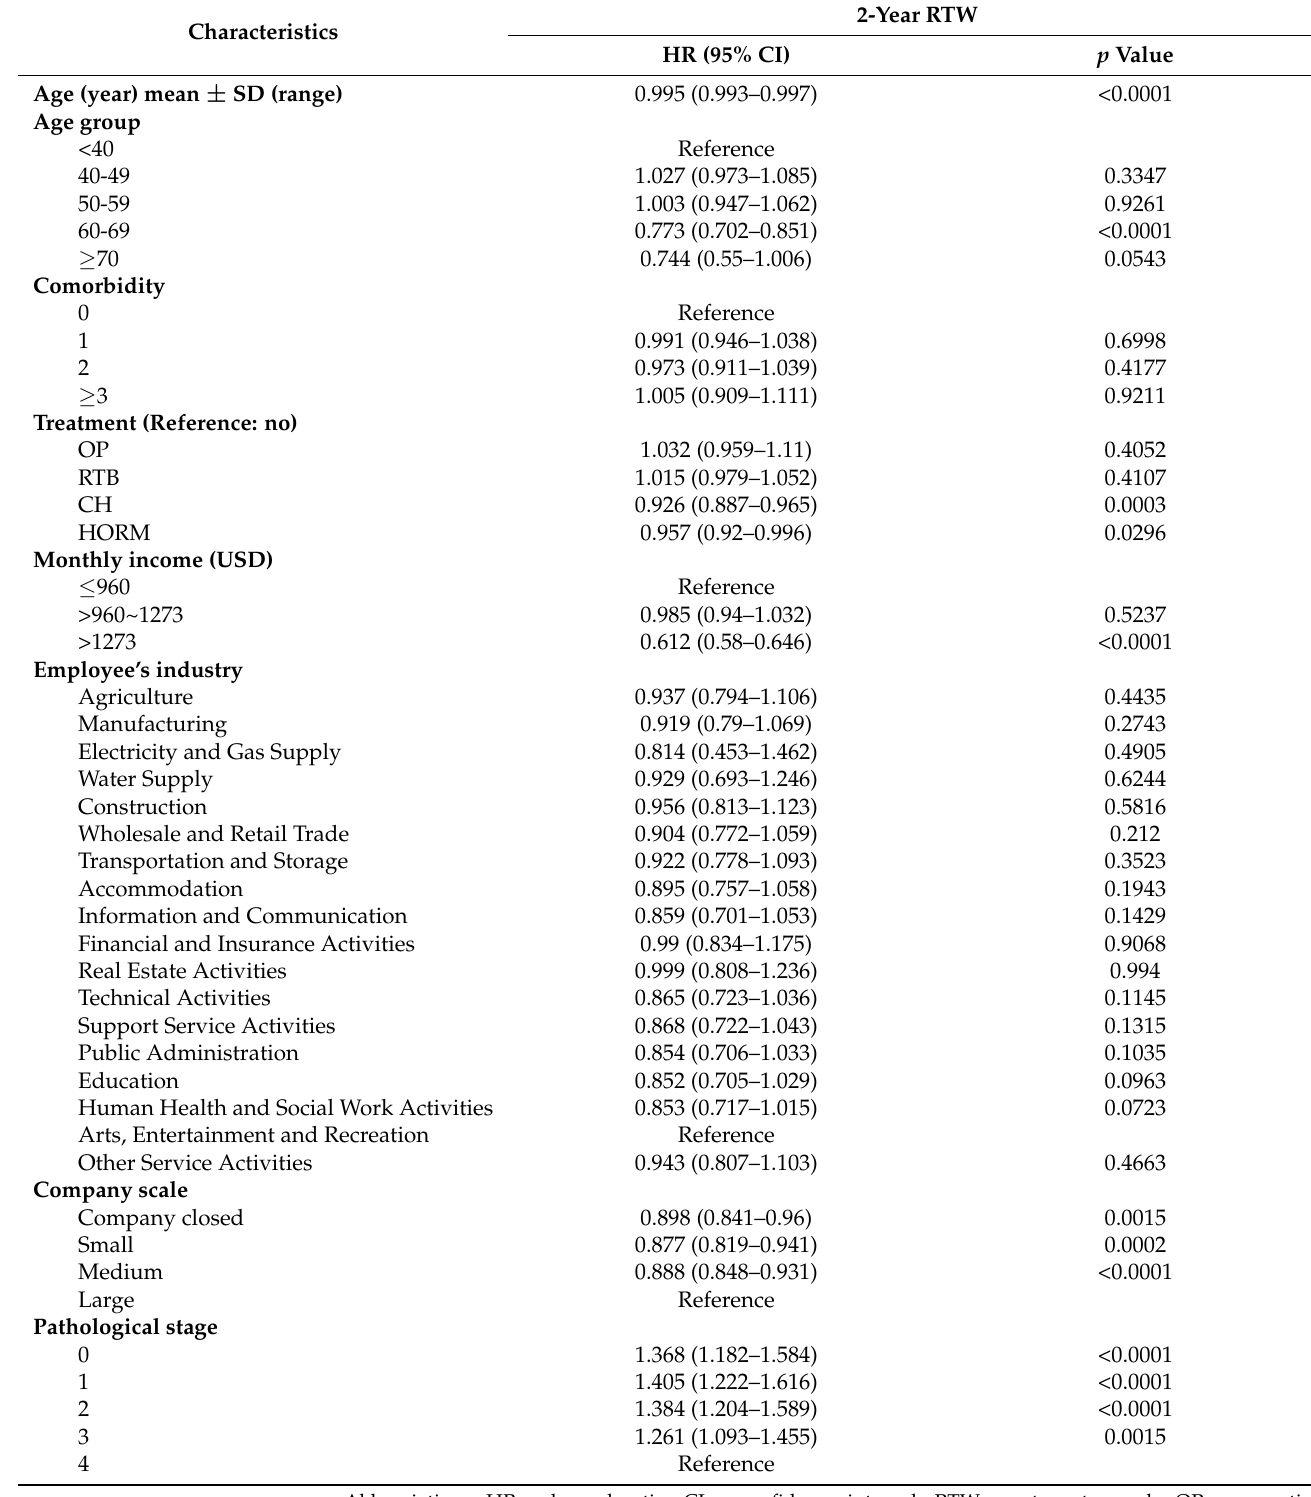
Table 3. Multivariate analysis of RTW in Cox proportional hazards